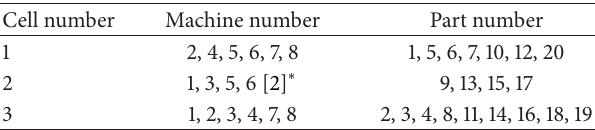
Table 10: A secondary solution for Example 2, after applying a new limit for maximum number machines in each cell.